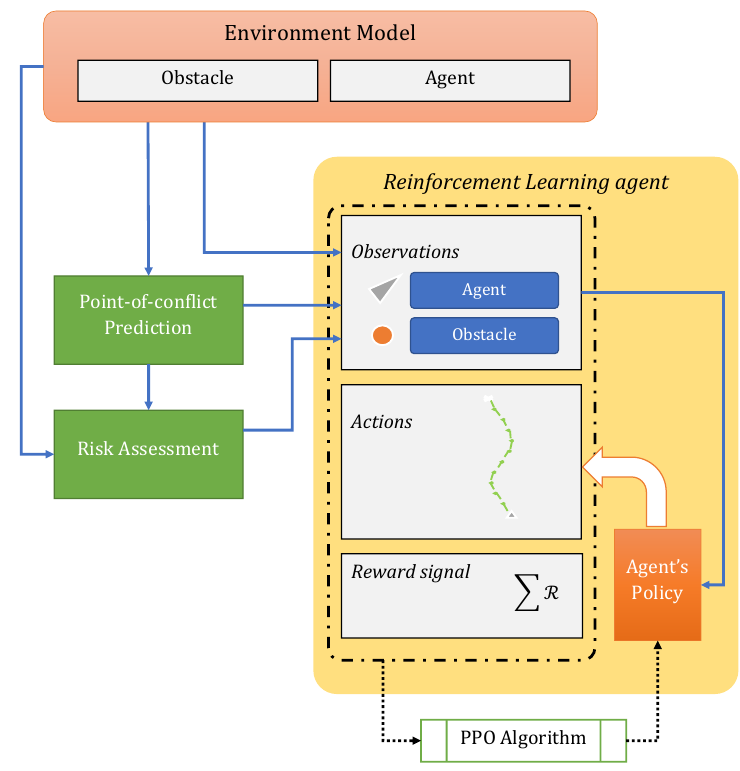
Figure 2. Overview of the pedestrian path-planning